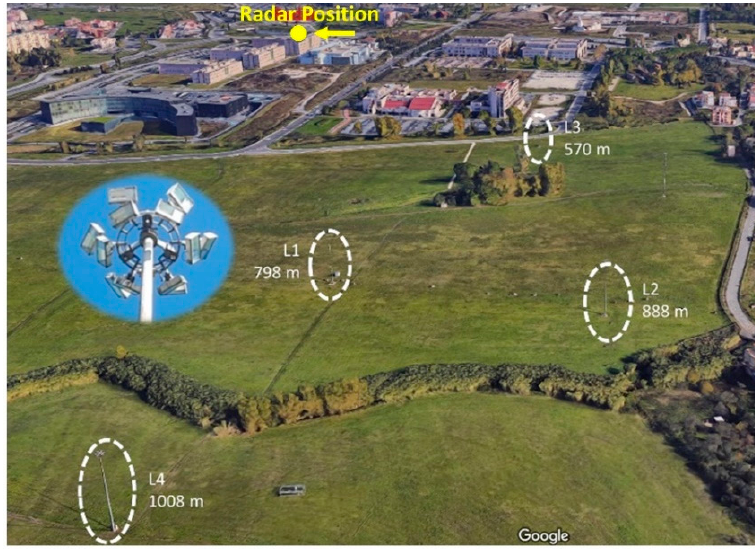
Figure 9. Overview (from Google Earth) of the trials environment at the Tor Vergata University area. The four opportunity targets (lampposts L1, L2, L3, and L4) are highlighted.